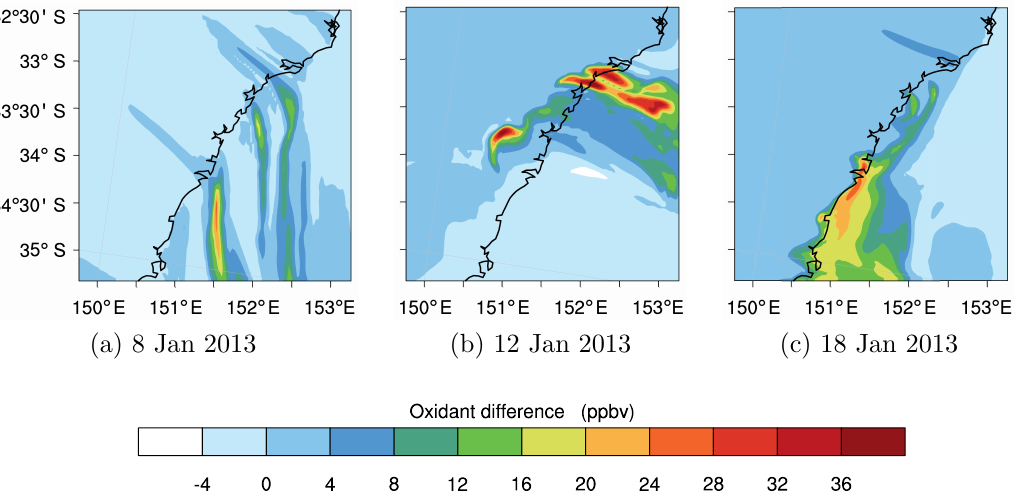
Figure 16. Simulated difference between O x from standard run and O x from average emissions run